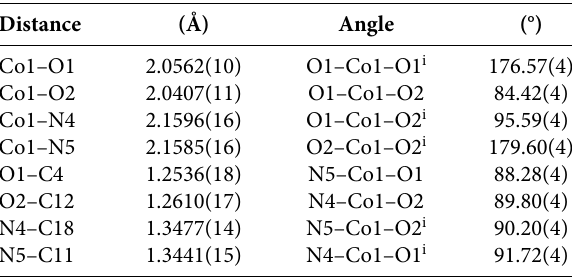
Table 2. Selected bond length (Å) and bond angle (°) for complex